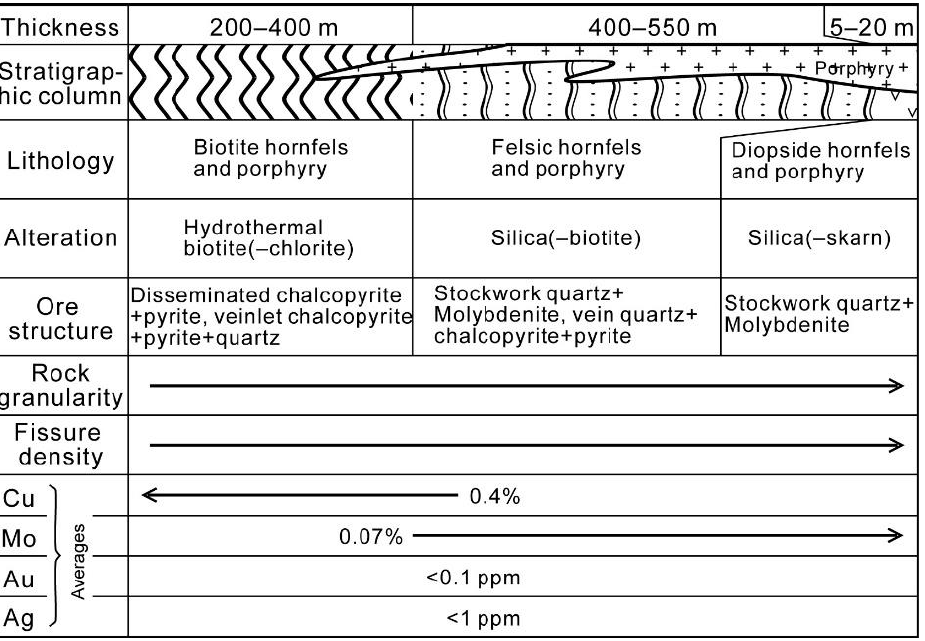
Figure 4. Characteristic lithologies, types of alteration, and mineralization in the different levels of the porphyry–hornfels orebody. Direction of arrows represent increasing trends.